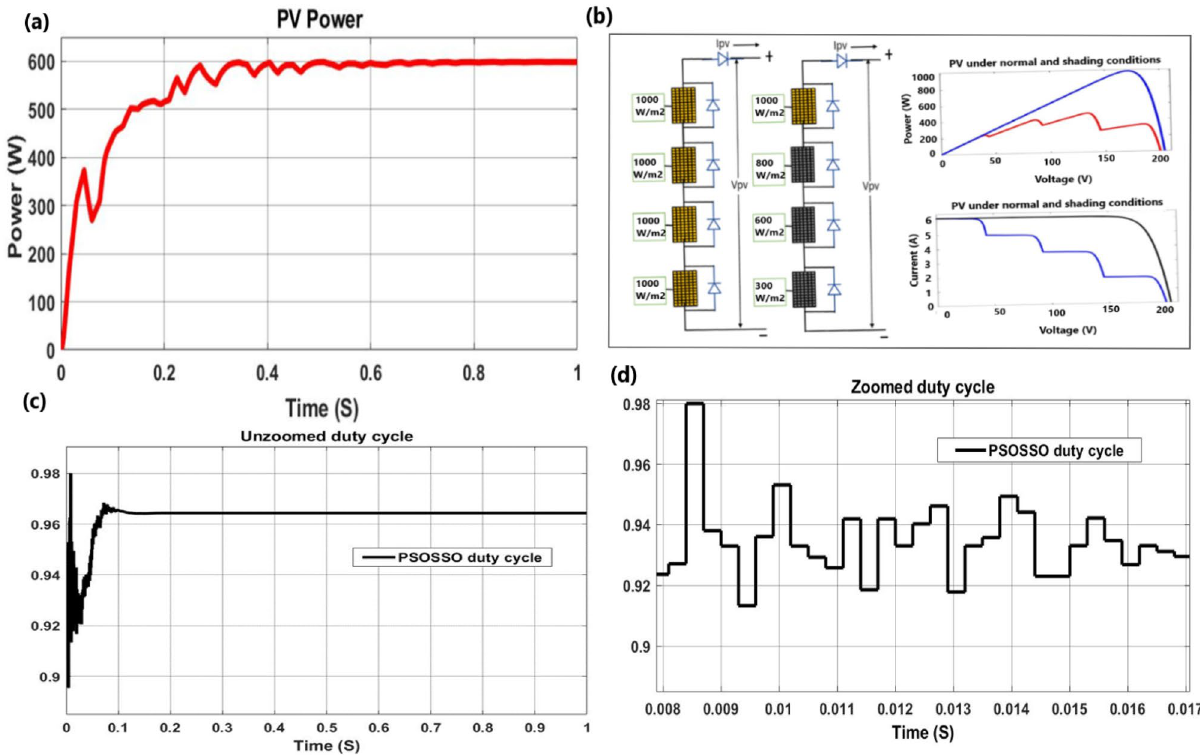
Figure 15. Tracking mechanism of PSOSSO under partial shading condition with nonlinear load (battery) connected.